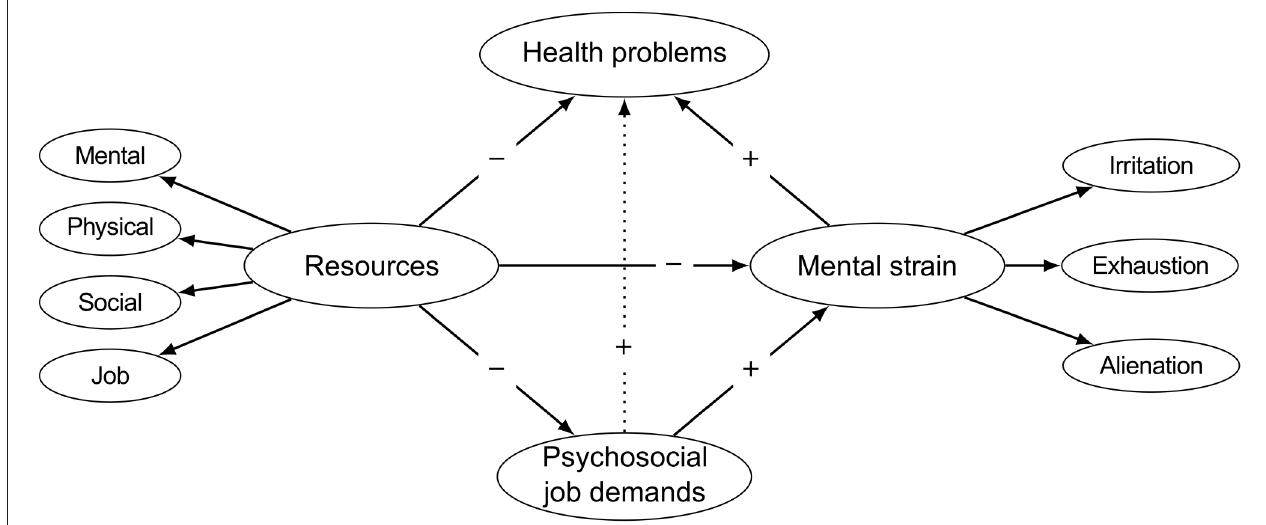
FIGURE 1 | Hypothesized relationships of the research model. “ + ” indicates a predicted positive relationship and “ − ” a predicted negative